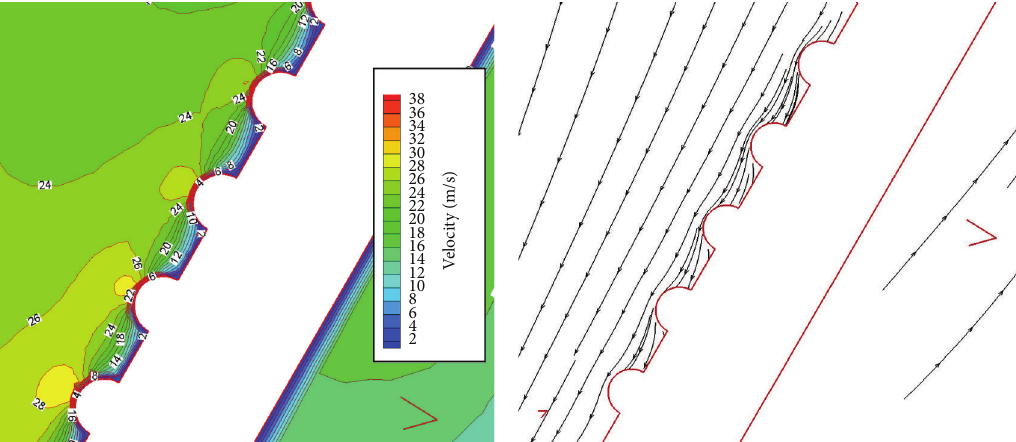
Figure 5: Flow velocity contours and path lines of the surface region of convex surface.